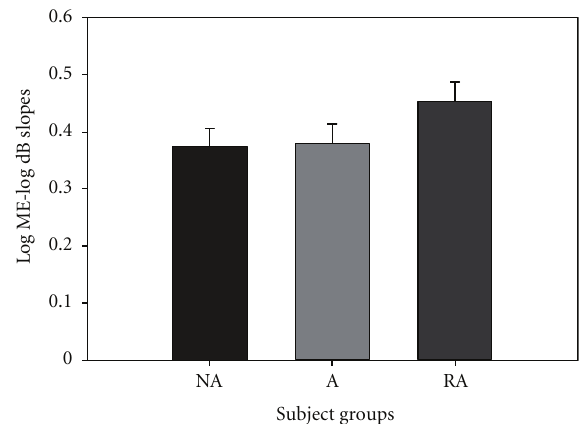
Figure 4: There was no significant di ff erence between the slopes for the 3 groups, NA, A, and LTA, for auditory magnitude estimation testing.